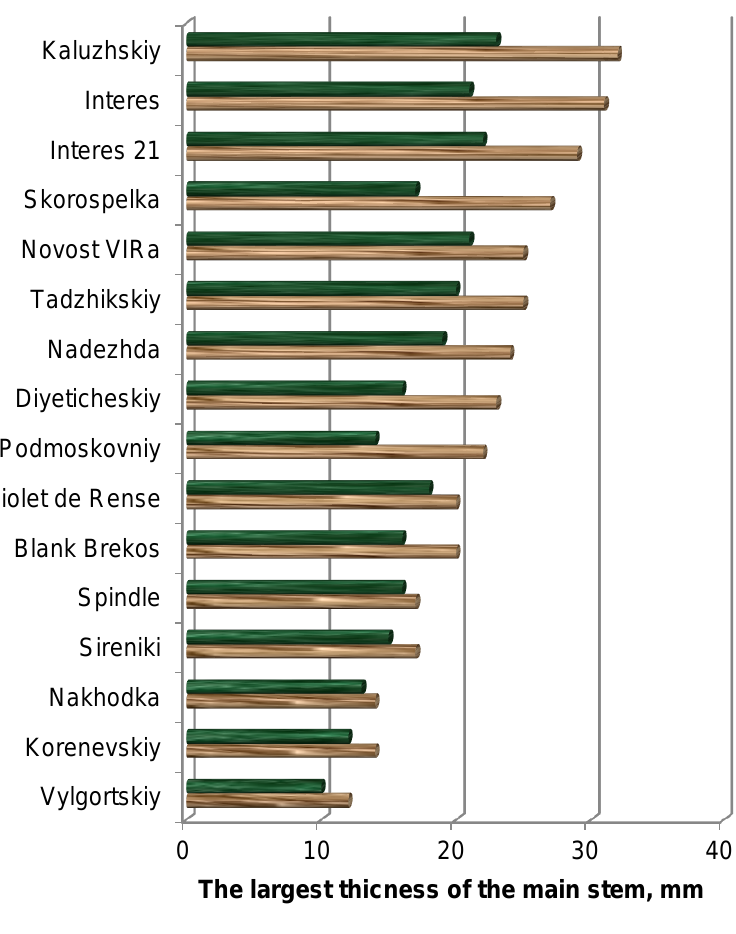
Figure 7. Thickness (diameter) of the main stem of different JA cultivars, mm .